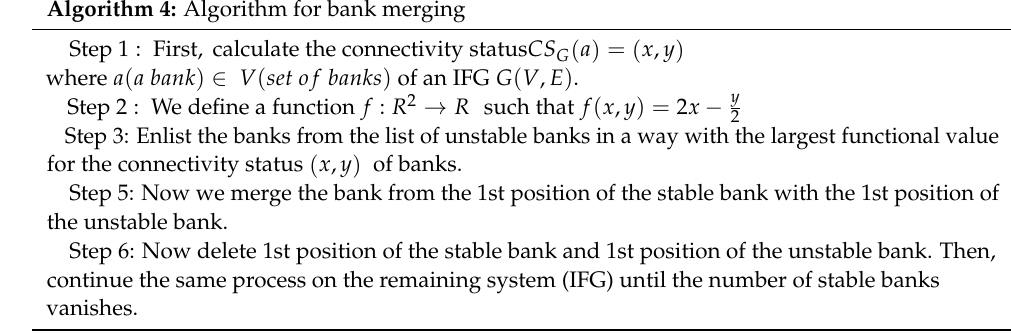
Algorithm 4: Algorithm for bank